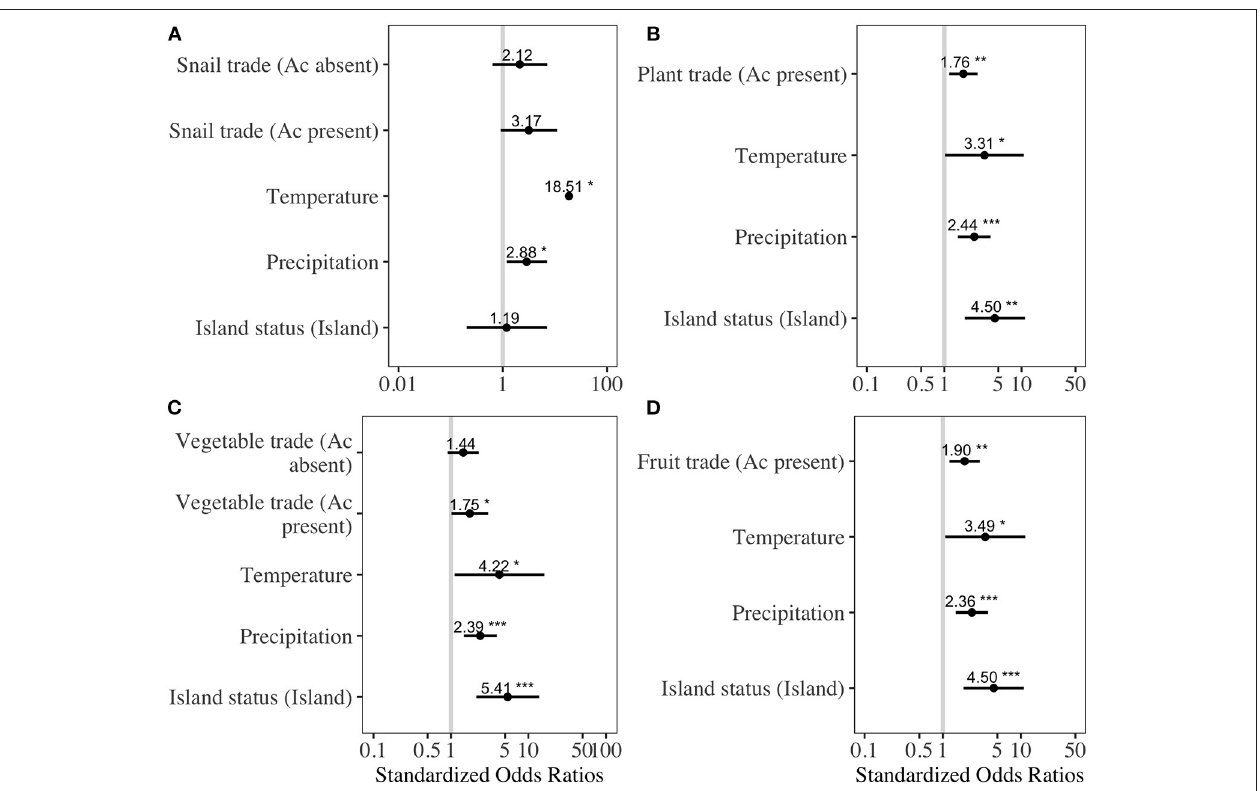
FIGURE 1 | Best-fitting regression models for the presence of Angiostrongylus cantonensis at the country level. To avoid overfitting, we fit separate models based on average annual traded quantities of (A) snails, (B) live plants, (C) vegetables, and (D) fruits. Ac present refers to product quantities exported from countries where A. cantonensis is present, and Ac absent refers to exports from countries where the parasite is absent. Dots indicate the standardized model estimates with bars representing 95% confidence intervals; vertical line is the line of null effect. Asterisks indicate the level of statistical significance (* = 0.05, ** = 0.01, *** =